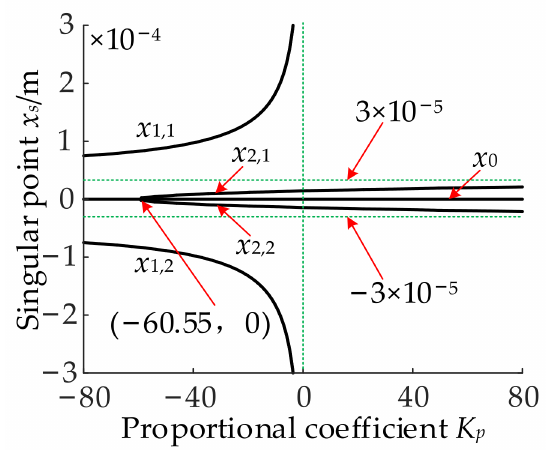
Figure 6. Static bifurcation of the single − DOF